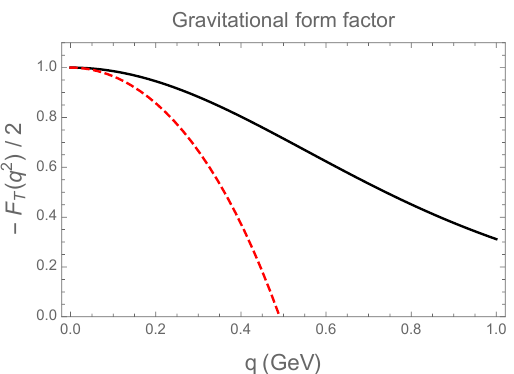
Figure 1 . Gravitational form factor (cid:0) F T ( q 2 ) = 2 as a function of the momentum transfer q in GeV. The black line corresponds to the exact expression obtained in ref. [20] and the same input parameters. The red-dashed line corresponds to the quadratic